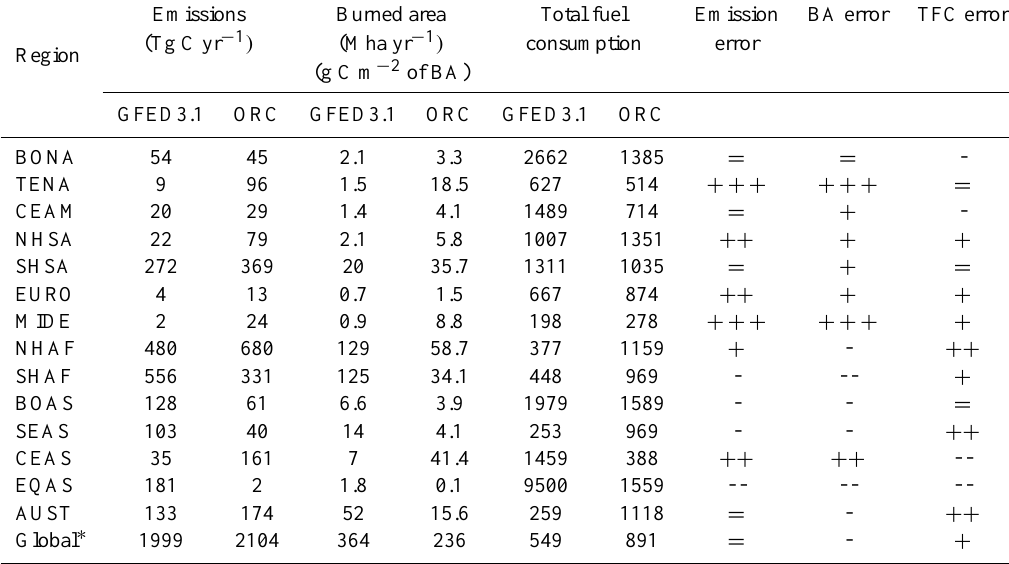
∗ For GFED3.1 data, burned area and emissions from all types of fires are included, i.e. forest fire, grassland fire, woodland fire, agricultural fire, deforestation and peatland